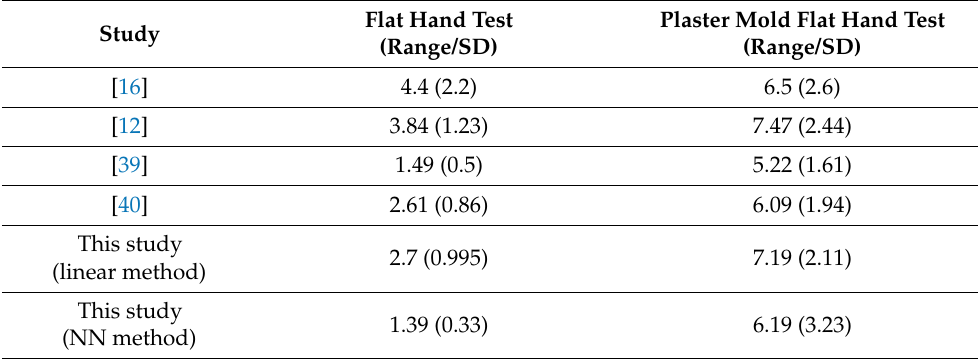
Table 8. Comparison of ‘flat hand’ and plaster mold test results from previous data glove research and results from this study. Range values represent the average range of measurements calculated for participants for each test within each study. SD represents the average standard deviation values for each test. Flat Hand Test Plaster Mold Flat Hand Study (Range/SD)